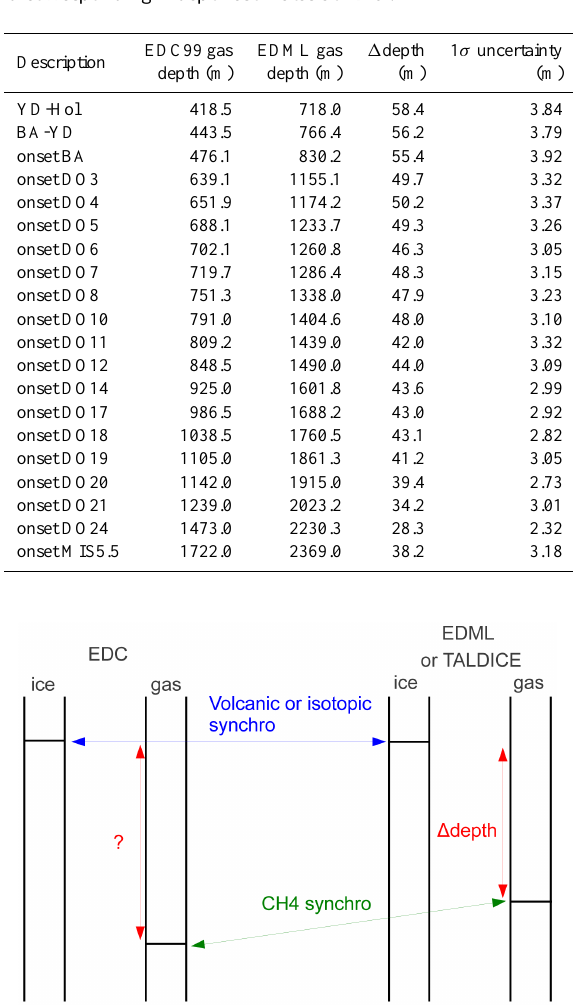
Table 1. CH 4 synchronisation tie points between EDC and EDML and corresponding 1 depth estimates at EDC.